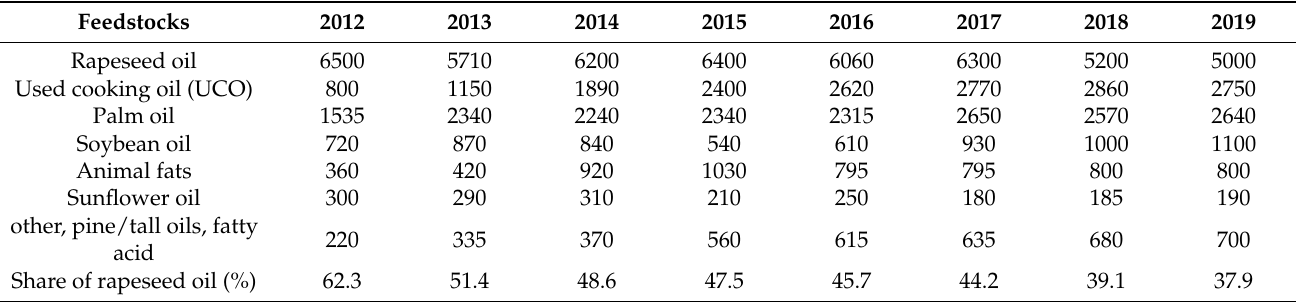
Table 2. The feedstock was used for biodiesel + renewable diesel (HVO; hydrotreated vegetable oil) in Europe from 2012 to